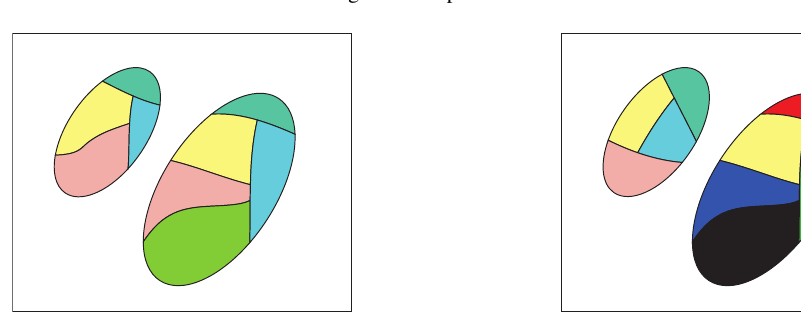
Fig. 6. Example of Defn. 2.